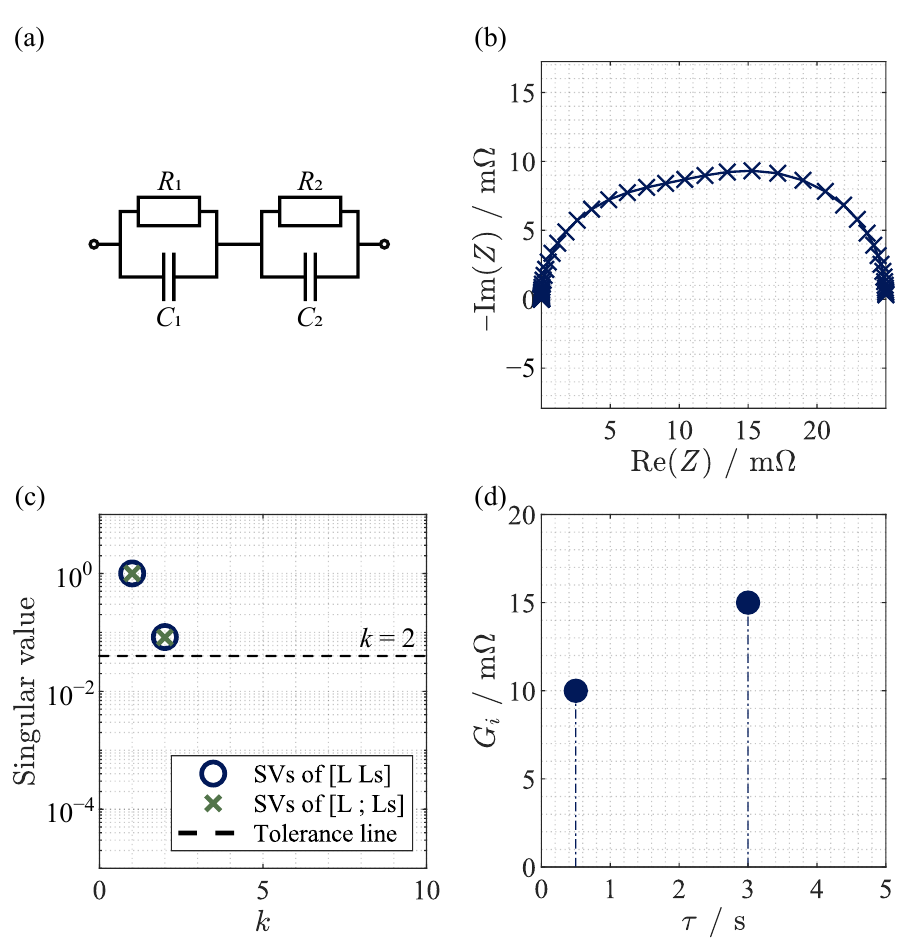
Figure 2. ECM for two RC elements ( a ), Nyquist plot of the impedance Z RC ( b ), SVD of the Loewner matrices ( c ), DG ( d